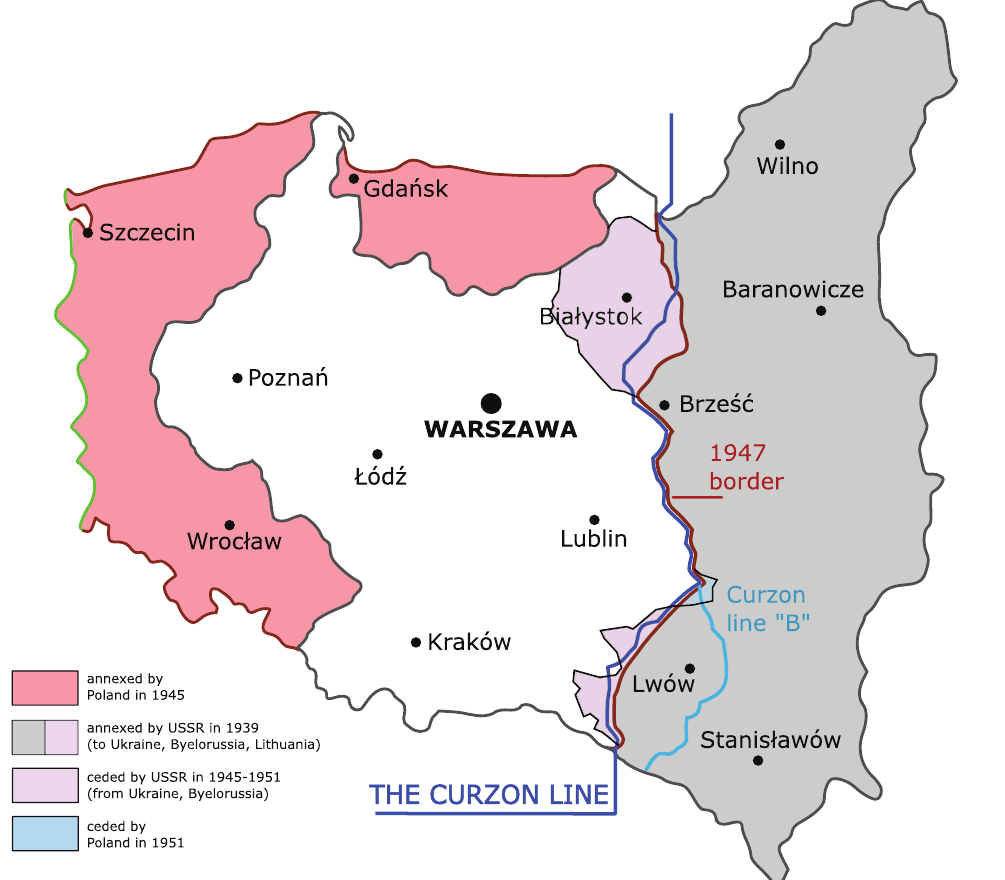
Figure 1. Map of the so‐called Recovered Territories. Source: Wikimedia Commons